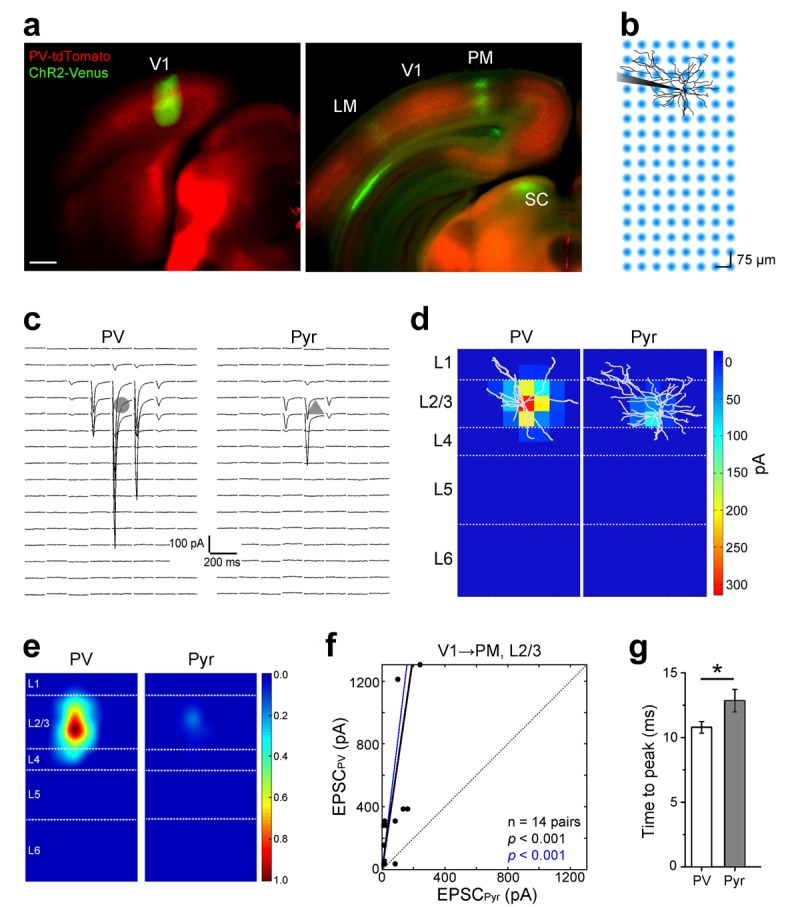
Subcellular ChR2-assisted mapping of V1→PM connections to L2/3 PV and Pyr cells.(a) Coronal slices showing injection (left) and target (right) sites two weeks after the injection of AAV2/1.CAG.ChR2-Venus.WPRE.SV40 into V1. Scale bar, 500 µm. Select target areas indicated in right panel. SC, superior colliculus. (b) Schematic of laser-scanning photostimulation of ChR2-expressing axon terminals during whole-cell recording of a biocytin-filled neuron. TTX and 4-AP are added to the bath solution, and the blue laser is delivered successively one spot at a time in a grid pattern separated by 75 µm. (c) EPSCssCRACM in a PV (left) and a neighboring Pyr (right) cell upon photostimulation. Grey shapes denote the location of the cell body of the recorded neuron. (d) Heat map of mean EPSCs within 75 µs after photostimulation for the EPSCs in 3c. Reconstructions of respective biocytin-filled neurons are superimposed on heat map. (e) Average heat map of 14 neighboring PV-Pyr cell pairs in L2/3 receiving V1→PM input, normalized to largest pixel value between a pair. PV cells receive substantially stronger input. (f) Scatter plot denoting the relative input strengths to 14 PV-Pyr cell pairs. Each data point represents a pair with the respective EPSCs in the PV (vertical axis) and the Pyr (horizontal axis) cell. The total EPSC in PV cells is significantly larger than that in neighboring Pyr cells (p<0.001, Wilcoxon signed-rank test). Solid black line: mean slope, blue line: mean slope after normalizing currents to mean cell conductance. (g) The mean time to peak of EPSCs after photostimulation is larger in Pyr cells than in PV cells (*p<0.05, paired t-test).